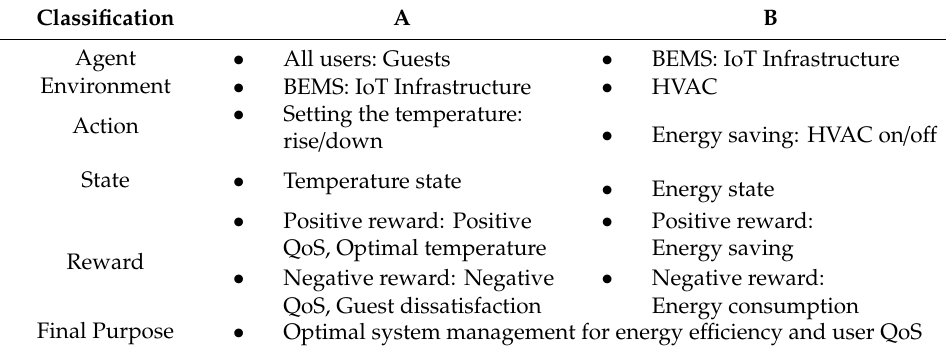
Figure 1. Reinforcement learning (RL)-based BEMS architecture. Table 2. Relationship between the Agent and Environment in the